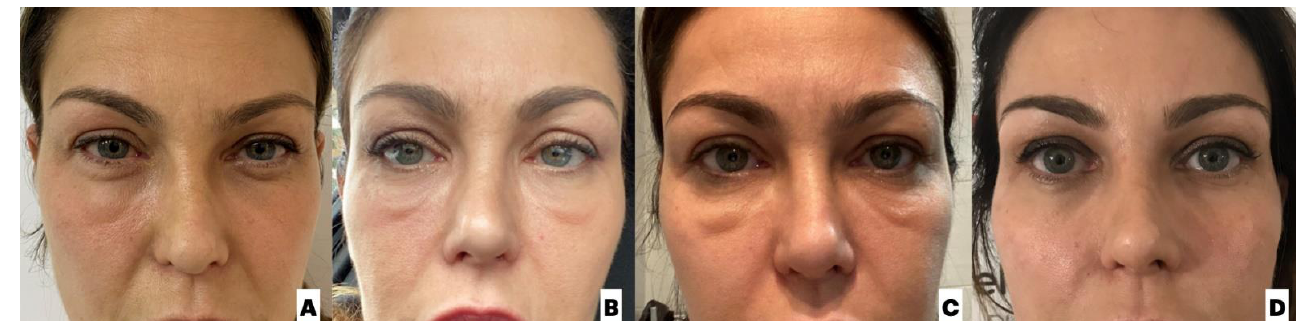
Figure 2. ( A ) A 44 year old lady experiencing a right lower eyelid edema with ipsilateral conjunctivitis, 1 week after the second dose of mRNA Pfizer-BioNTech COVID-19 vaccine; ( B ) The same patient experiencing bilateral lower eyelid edema approximately 1 year following Juvederm Volbella (Allergan, Irvine CA) injections; ( C ) Clinical appearance of the patient three weeks following a second session of hyaluronidase injections; ( D ) Resolution of late-onset tear trough edema following three sessions of